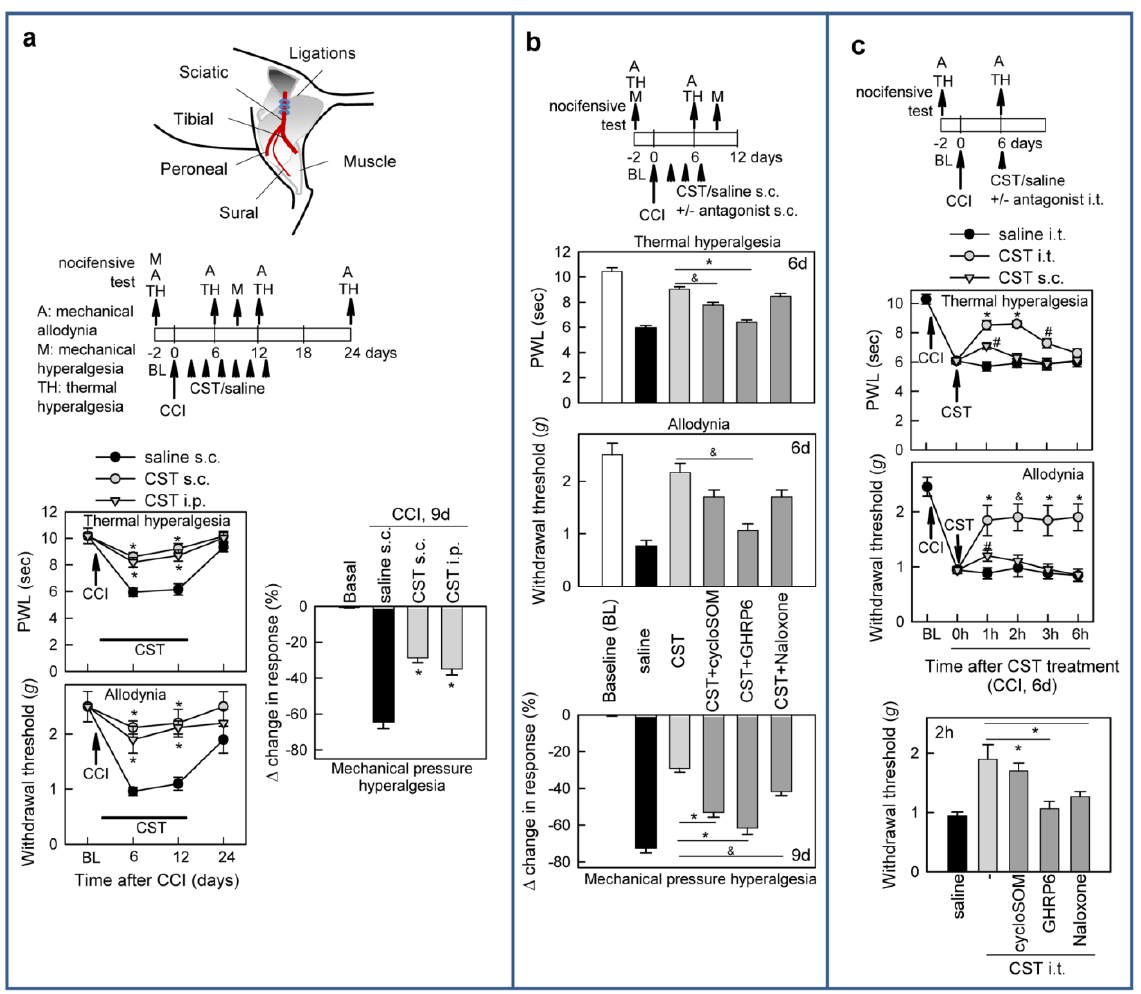
Figure 2. Cortistatin attenuated neuropathic pain caused by chronic constriction injury (CCI) of the sciatic nerve. ( a ) Effects of local (s.c. 1 µg) and systemic (i.p., 2 µg) cortistatin injection (every other day starting 2 days after CCI surgery until day 13, as indicated in the scheme) on thermal hyperalgesia represented by paw withdrawal latency (PWL) in response to radiant heat, on mechanical/tactile allodynia represented by the withdrawal threshold (in g) to plantar von Frey hair application in hind paws (ipsilateral to injured nerve), and on mechanical pressure hypersensitivity represented as the percentage of decrease in the pressure threshold in the ipsilateral paw over the contralateral paw to injured nerve, prior to CCI (BL, baseline) or at different times after CCI surgery. n = 6 mice/group. * p < 0.0001 vs. saline-treated mice. ( b ) Reversal of cortistatin-induced relief of CCI-induced pain behavior by antagonists of sstr (cycloSOM), ghrelin-receptor (GHRP6), and opioid-receptor (naloxone) administered locally (s.c.), as described in the scheme. n = 6 mice/group. * p < 0.0001, & p < 0.01 vs. cortistatin-treated mice. ( c ) Effects of a single local (s.c. 1 µg) or central (i.t., 20 ng) cortistatin injection on thermal hyperalgesic and allodynic responses measured 6 days after CCI induction. Lower panel: effects of i.t. administration of antagonists for sstr, ghrelin-receptor, and opioid-receptor on the anti-allodynic effect of cortistatin (measured 2 h after i.t. cortistatin injection). n = 6 mice/group. * p < 0.0001, & p < 0.01, # p < 0.05 vs. saline-treated mice in upper panels, and vs. cortistatin-treated mice in lower panel. All data represent mean ± SEM.